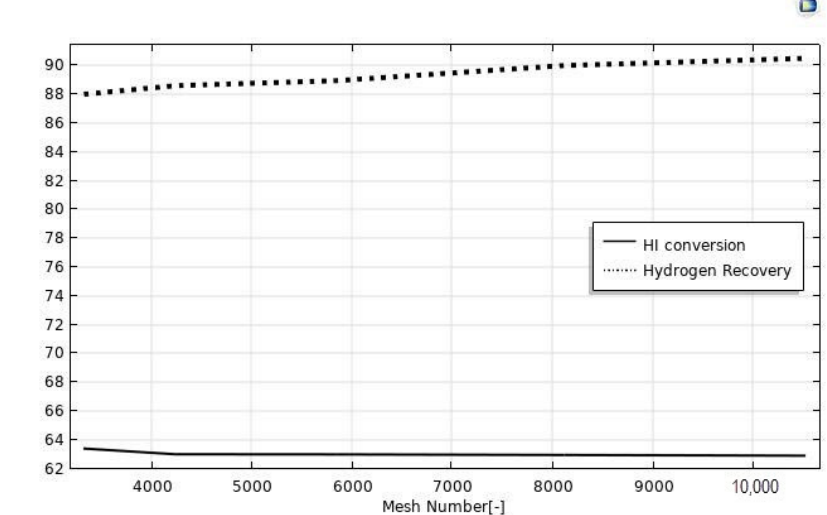
Figure 2. HI conversion and hydrogen recovery as a function of the mesh number. CFD simulations made at p = 1 bar, T = 400 ℃ , sweep gas flow rate = 333.33 mm 3 /s, and feed flow rate = 20 mm 3 /s.